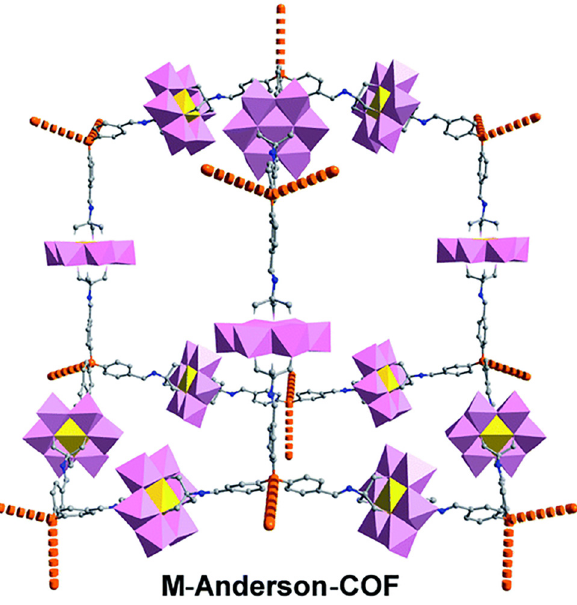
Figure 16: Synthetic approach and structuralevaluation of POMCOF M-Anderson-COF. Adopted with permission from ref. [153].